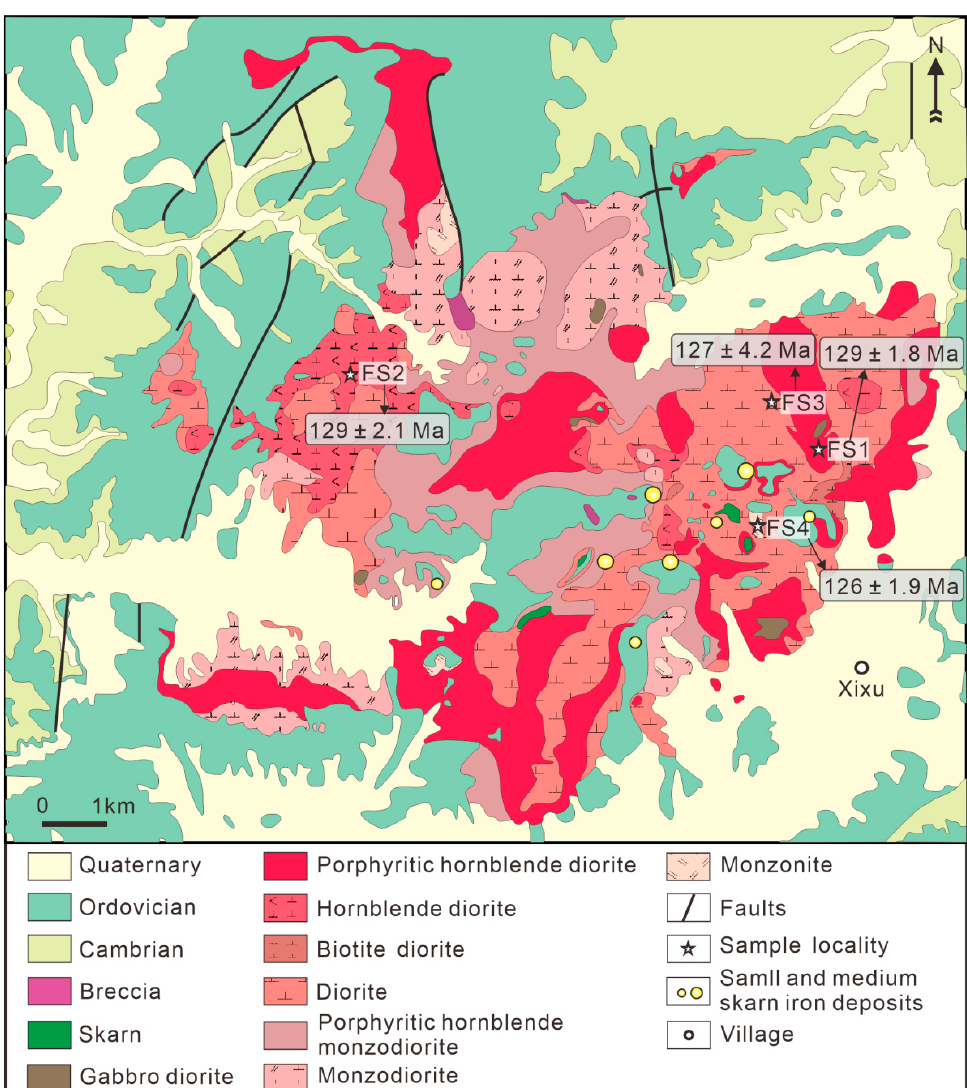
Figure 2. Geological map of the Fushan complex (modi fi ed after [55]). Age data are from [58].